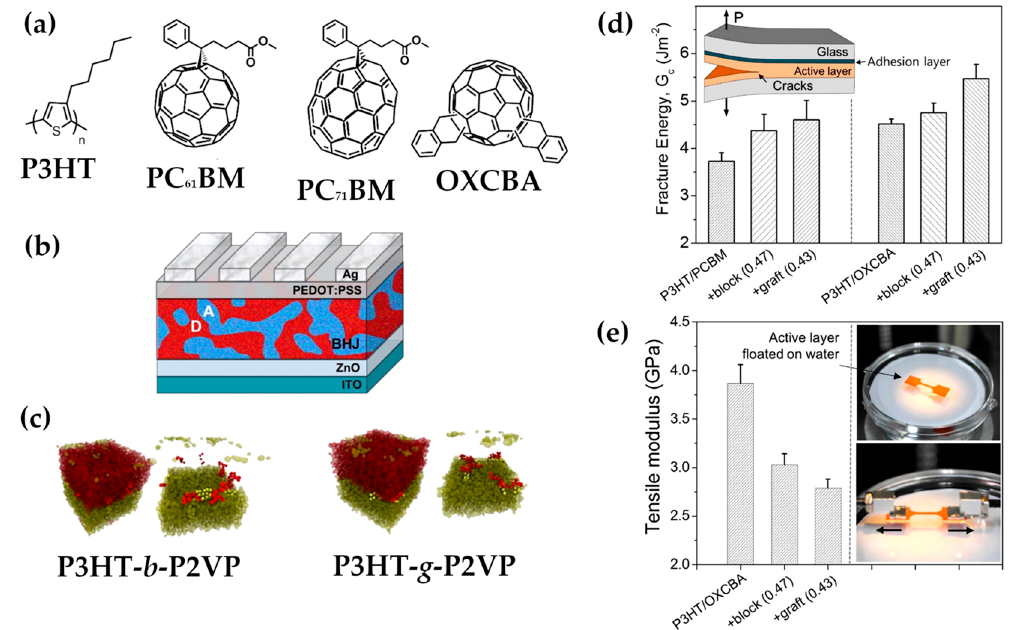
Figure 5. Poly(vinylpyridine)-based CBs. ( a ) Chemical structures of the polymer electron donor (P3HT) and fullerene-derivative electron acceptors (OXCBA, PCBM, and PC71BM). ( b ) Scheme of the inverted solar cell. ( c ) Models for the molecular configurations at the D / A interfaces for the poly(3-hexylthiophene) -block-poly(2-vinylpyridine) (P3HT- b -P2VP) and the poly(3-hexylthiophene)-graft-poly(2-vinylpyridine) (P3HT- g -P2VP). E ff ect of the P3HT- b -P2VP and P3HT- g -P2VP on ( d ) fracture energy and ( e ) tensile modulus of P3HT:PCBM and P3HT:OXCBA BHJ films. Reprinted with permission from Reference [135]. Copyright 2014 American Chemical Society.